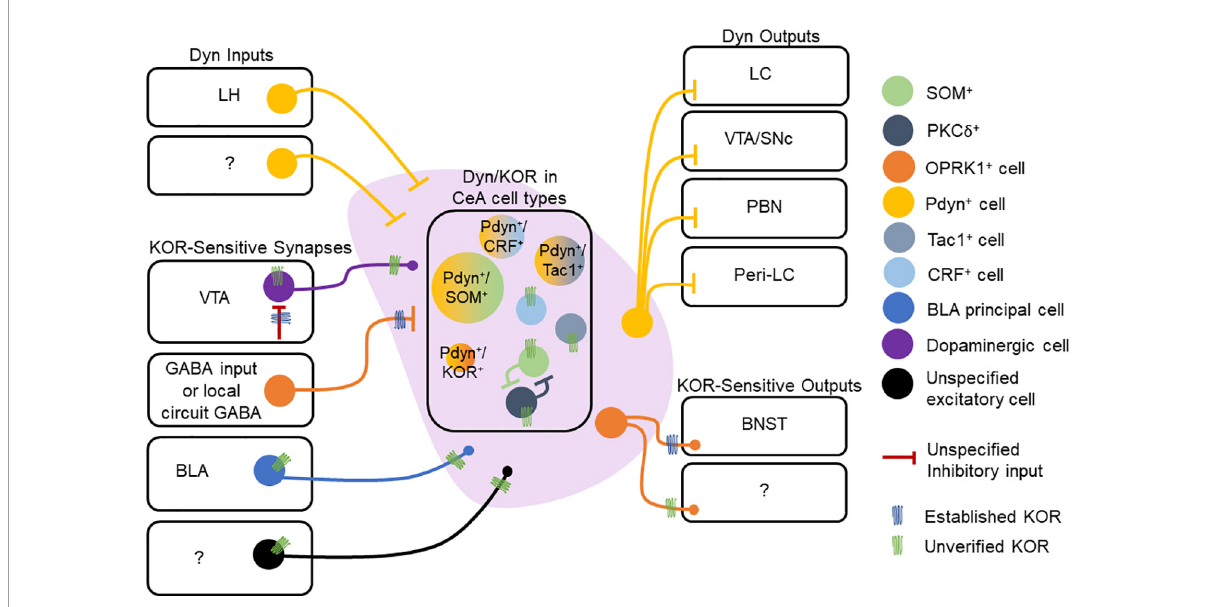
FIGURE3 Dynorphin/kappa opioid receptor expression in central amygdala (CeA) circuitry. Dyn is expressed in multiple cell types within the CeA. Extrinsic Dyn inputs to the CeA arise from lateral hypothalamus (LH), but other sources remain unknown. Presynaptic KOR regulation of inhibitory synapses onto CeA neurons has documented, but the source of KOR + GABA neurons is not known. Other inputs to the CeA may also express KOR, including those arising from the VTA, basolateral amygdala (BLA), and other uncharacterized regions. Within the CeA, KOR expression within specific cell types is not understood. KORs may directly hyperpolarize or inhibit collaterals established by CeA neurons. CeA projections to the BNST are inhibited by presynaptic KORs. KOR expression at other CeA neuron outputs has not been demonstrated. CeA Dyn neurons are known to project to multiple regions including the LC, VTA/SNc, PBN, and Peri-LC. The molecular profiles of Dyn neurons may also vary across the CeA’s medial and lateral subdivisions, which we are omitted in the